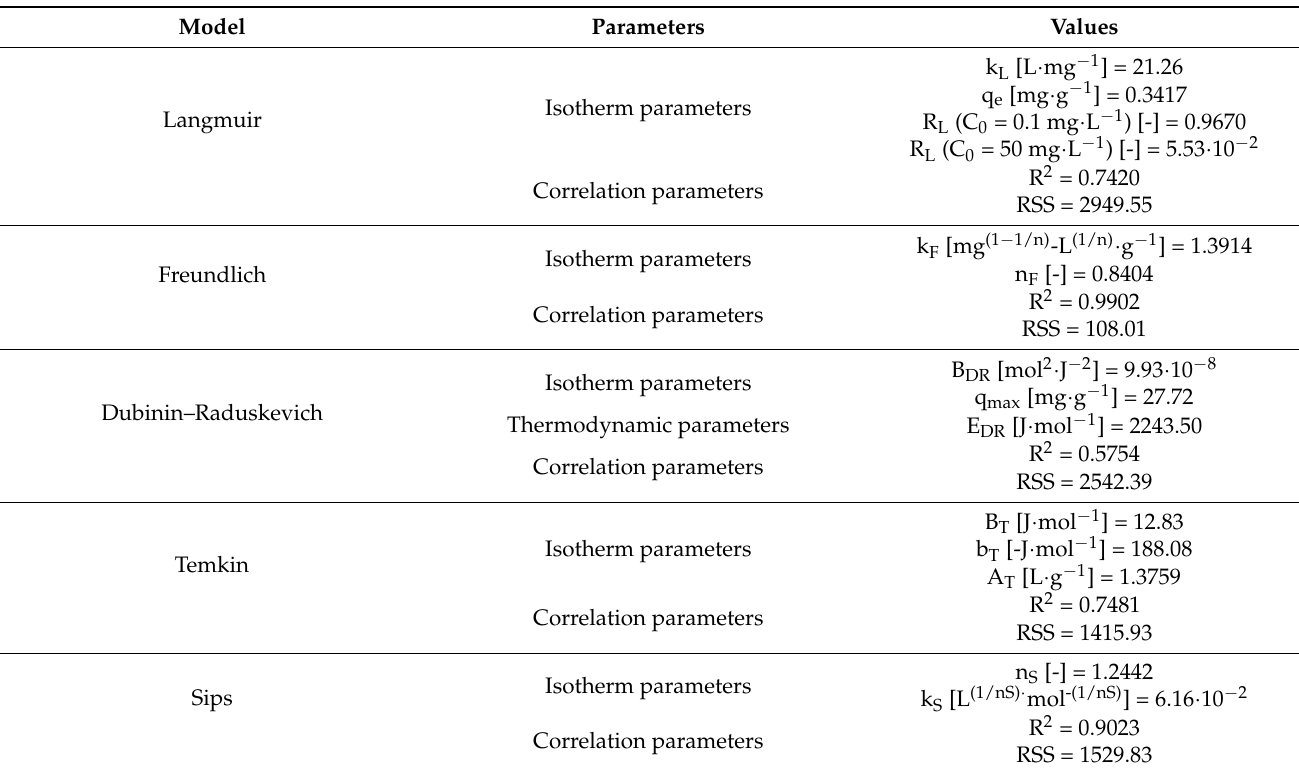
Figure 13. The isotherm experimental data and isotherm model adjustment of the Langmuir, Fre- undlich, Temkin, Dubinin–Raduskevich, and Sips equations. Table 4. The results of the isotherm model adjustment to the adsorption equilibrium data of hexava- lent chromium on a CNF